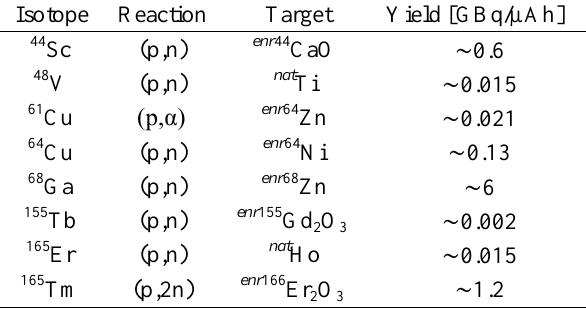
Table 1. Main achievements in non-standard radioisotope production obtained with the STS at the Bern medical